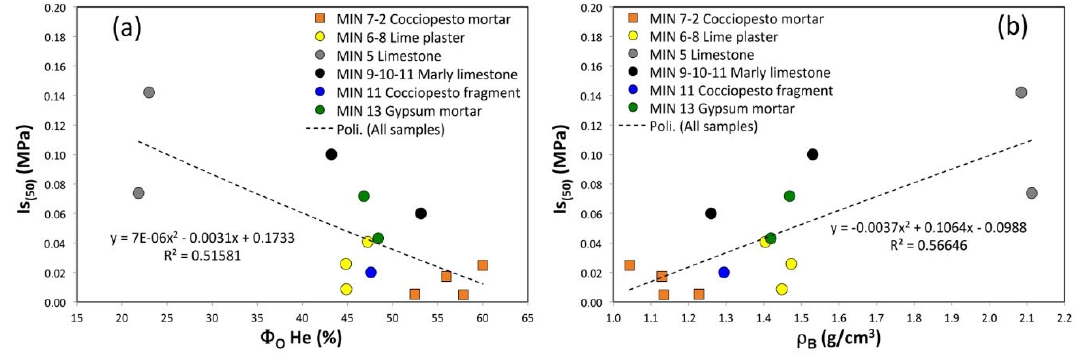
Figure 14. Binary charts which plot the physical-mechanical properties by Point Load Test of samples taken from Area B and house-fort of Cap de Forma archaeological site. ( a ) helium open porosity ( Φ O He) vs. punching strength index (Is (50) ); ( b ) bulk density ( ρ B ) vs. punching strength index (Is (50) ).